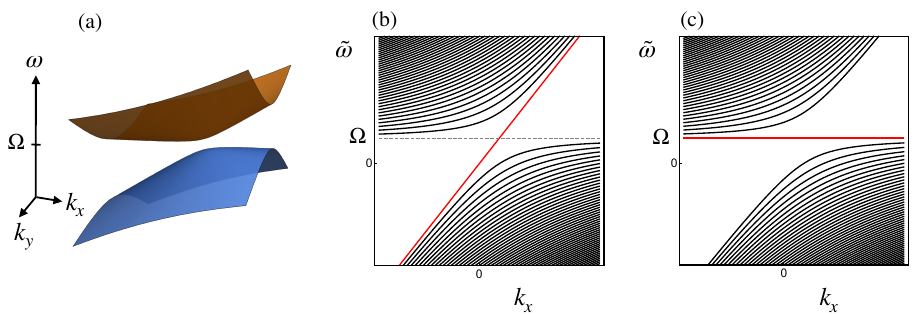
Figure 5: Frequency spectra of the polariton-like toy model for (a) the homogeneous (symbol Hamiltonian) problem, and (b) and (c) the inhomogeneous (operator Hamil- tonian) problem, for (b) m ( y ) ∝ y and (c) m ( y ) ∝ − y . The dashed line indicates the absence of a direct